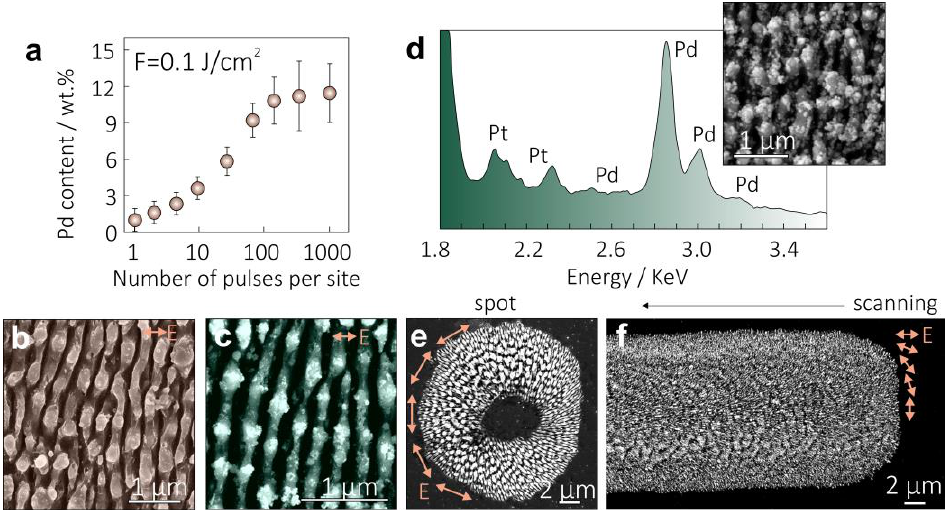
Figure 3. ( a ) Averaged amount of Pd in the Si nanogratings as a function of the number of laser pulses N applied per surface site. Pd content was averaged over 10 different surface sites produced at identical conditions. Experiments were carried out at fixed laser fluence F = 0.1 J/cm 2 and working solutions containing 10 −3 M of H 2 PdCl 4 . ( b , c ) Representative SEM images of Si nanogratings decorated with Pt and Ag NPs, respectively. ( d ) EDX spectrum of the Si nanogratings produced in aqueous solution containing 10 −3 M of H 2 PdCl 4 and 10 −4 M of K 2 [PtCl 6 ]. ( e , f ) SEM images of Pd-decorated Si nanogratings with characteristic periods of 250 ( e ) and 70 nm ( f ) recorded with an azimuthally polarized donut-shaped laser beam at F = 0.1 J/cm 2 . The 250 nm period nanograting was produced by applying N = 25 laser pulses per surface site, while the 70 nm period was produced by scanning the sample surface at v = 1 µm/s at pulse repetition rate of 1 KHz. Arrows in all SEM images demonstrate the polarization direction.